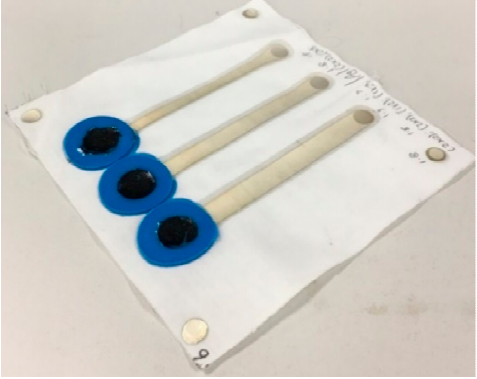
Figure 3. Complete screen-printed electrodes.